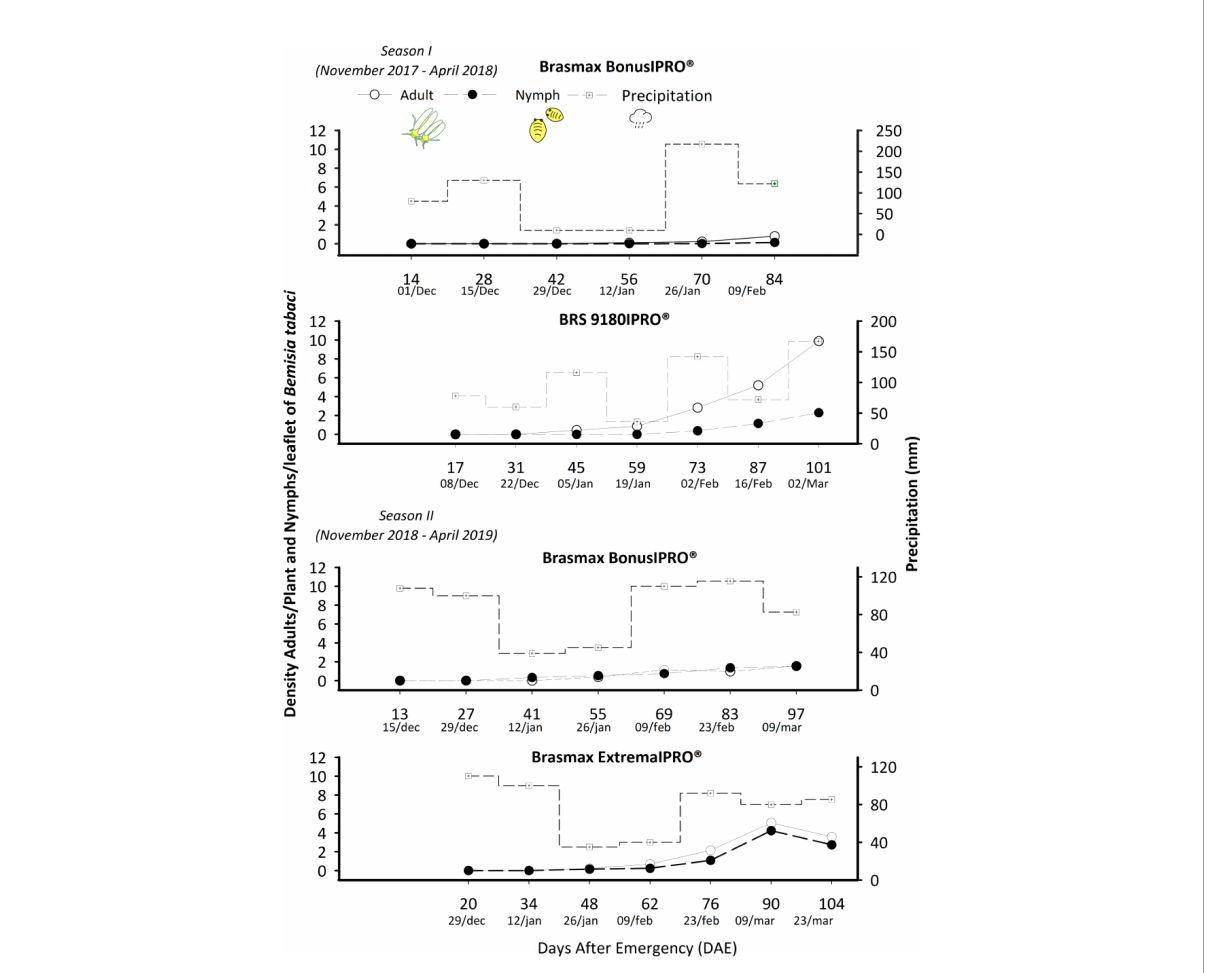
FIGURE 3 Population density of Bemisia tabaci adults and nymphs in the Brasmax Bonus IPRO ® , BRS 9180IPRO ® and Brasmax ExtremaIPRO ® cultivars in seasons I and II and